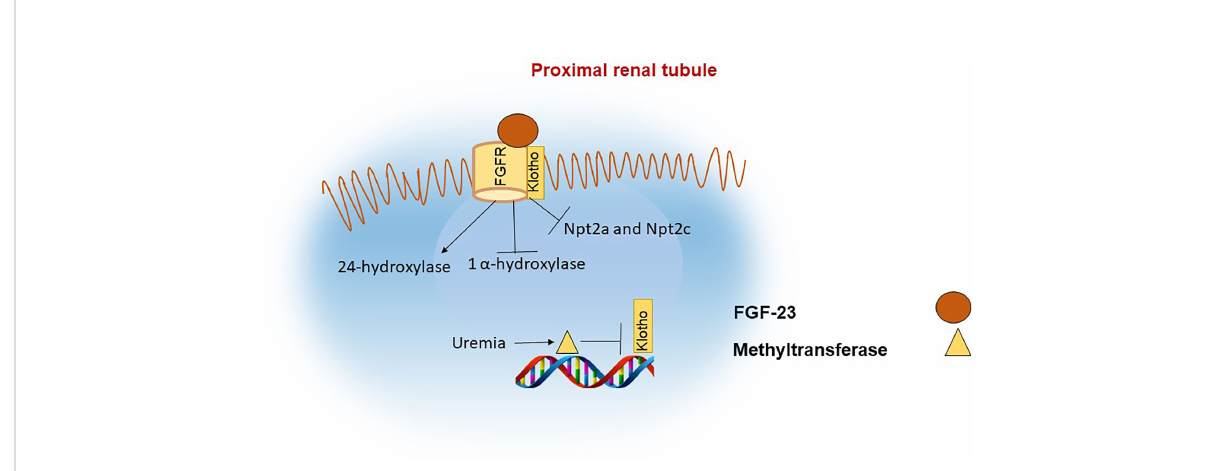
FIGURE 2 FGF-23 actions in the proximal renal tubule. In the proximal renal tubule FGF-23 binds to the FGF receptor and its coreceptor Klotho. The actions of FGF-23 include inhibition of 1 a hydroxylase and of the phosphate channels NPT2a and NPT2c with the net effect of decreasing phosphate reabsorption in the kidneys and indirectly reducing phosphate absorption in the intestine due to reduced levels of 1,25(OH) 2 D. Klotho synthesis is reduced in renal failure, in part as a result of increased methylation of the klotho